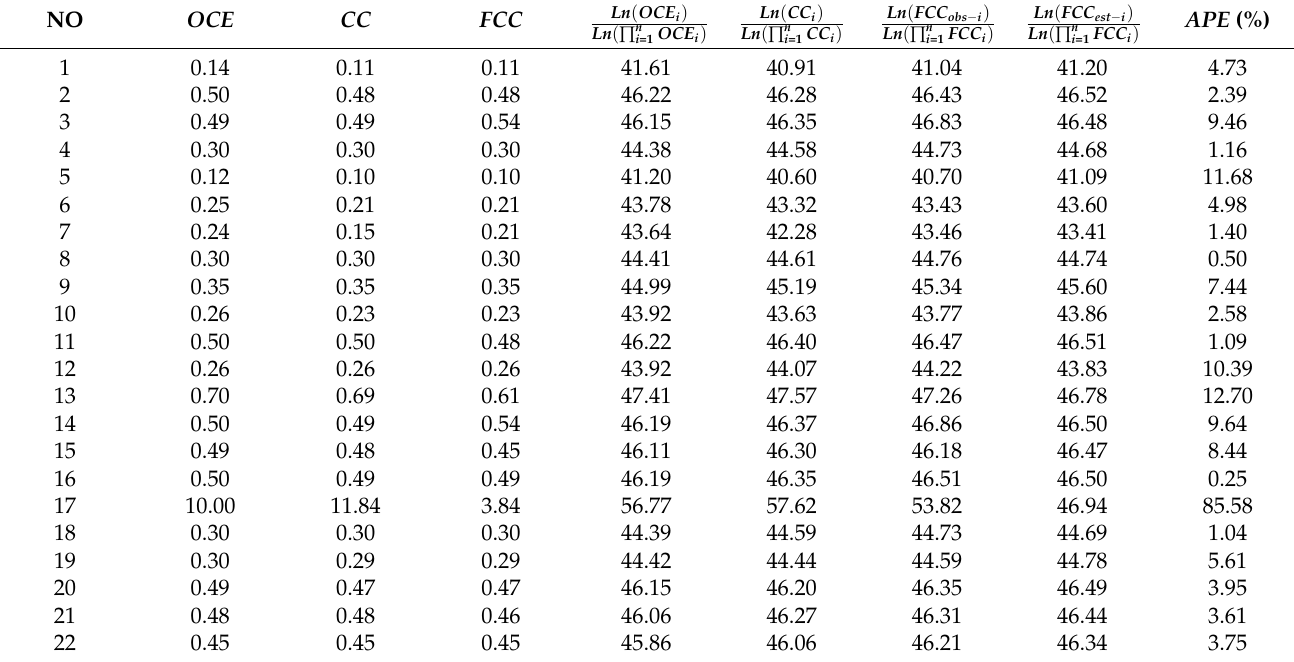
Table 6. The twenty-two data sets after eliminating the APE values greater than